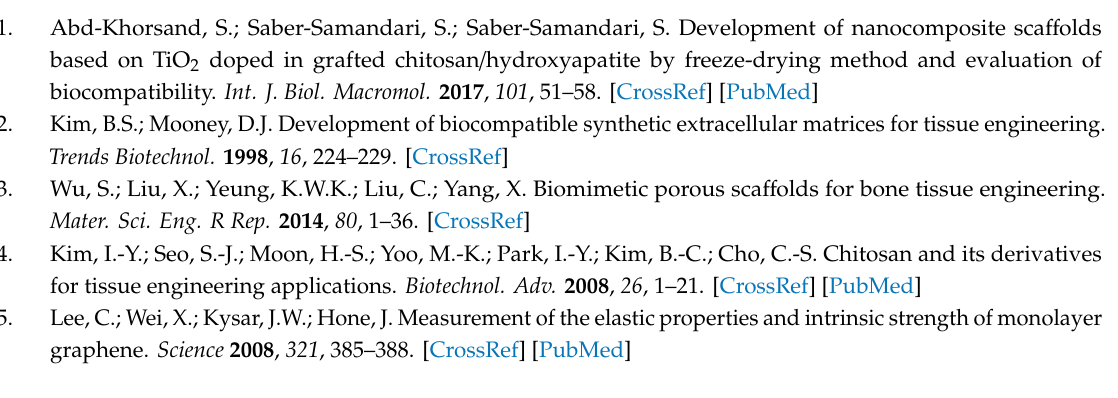
Supplementary Materials: Supplementary material Table S1 can be found at http: // www.mdpi.com / 1422-0067 / 20 / 12 / 2987 /